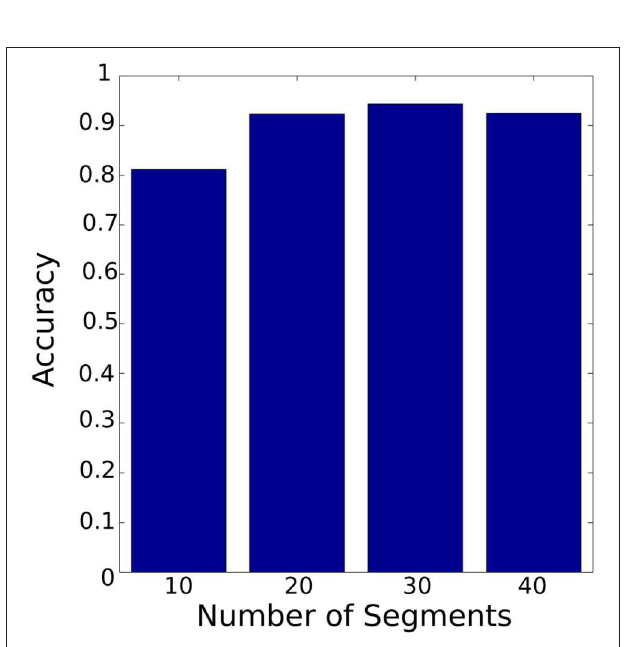
FIGURE 13 | Symbolic representation with five segments using K-means.